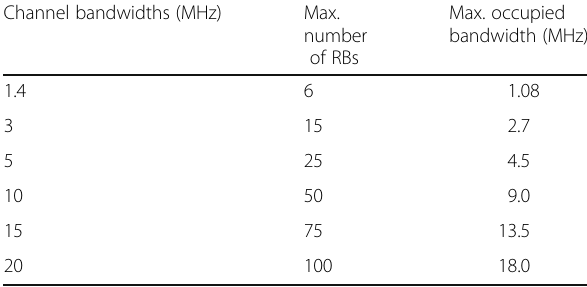
Table 1 LTE transmission bandwidth configuration Channel bandwidths (MHz) Max.